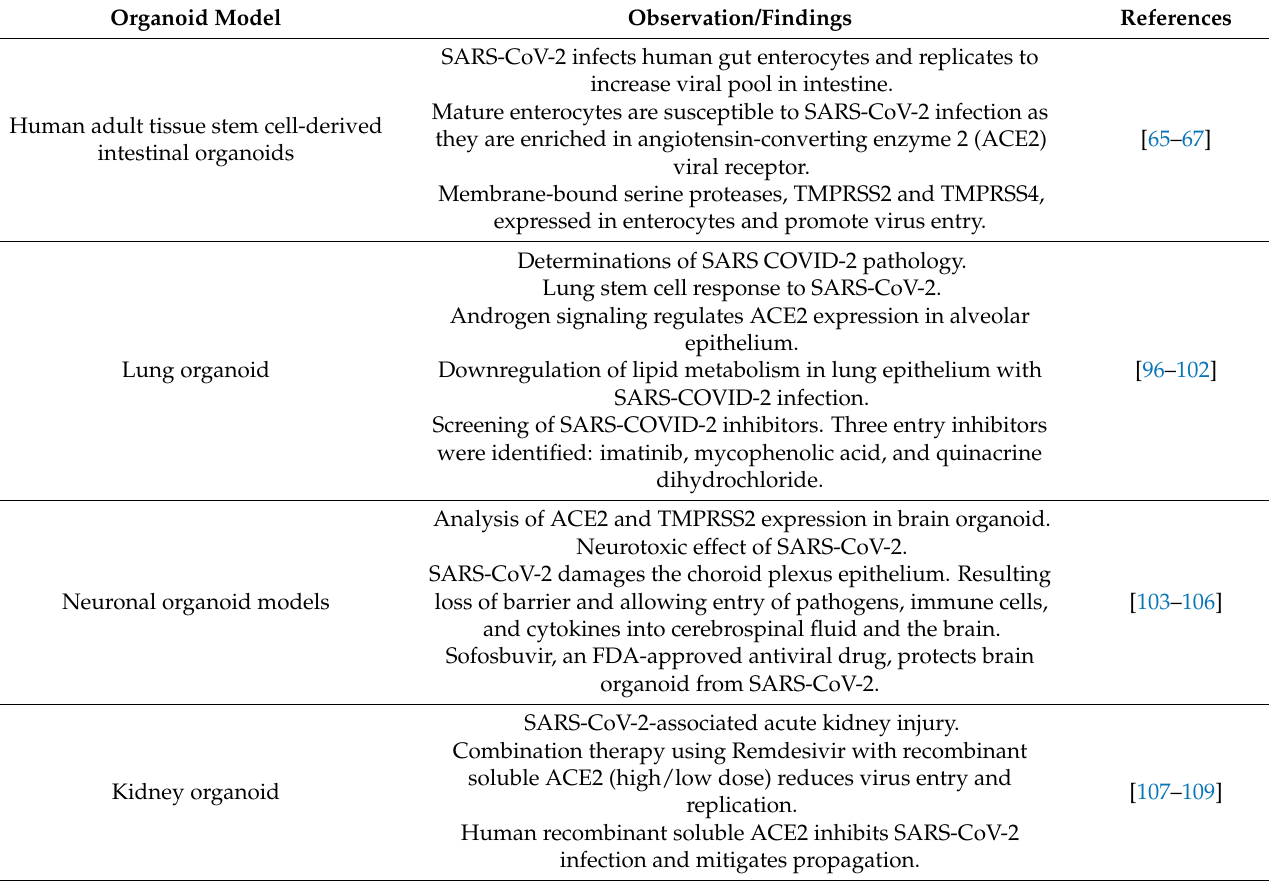
Table 1. Summary of organoid models in SARS-CoV-2 study. Organoid Model